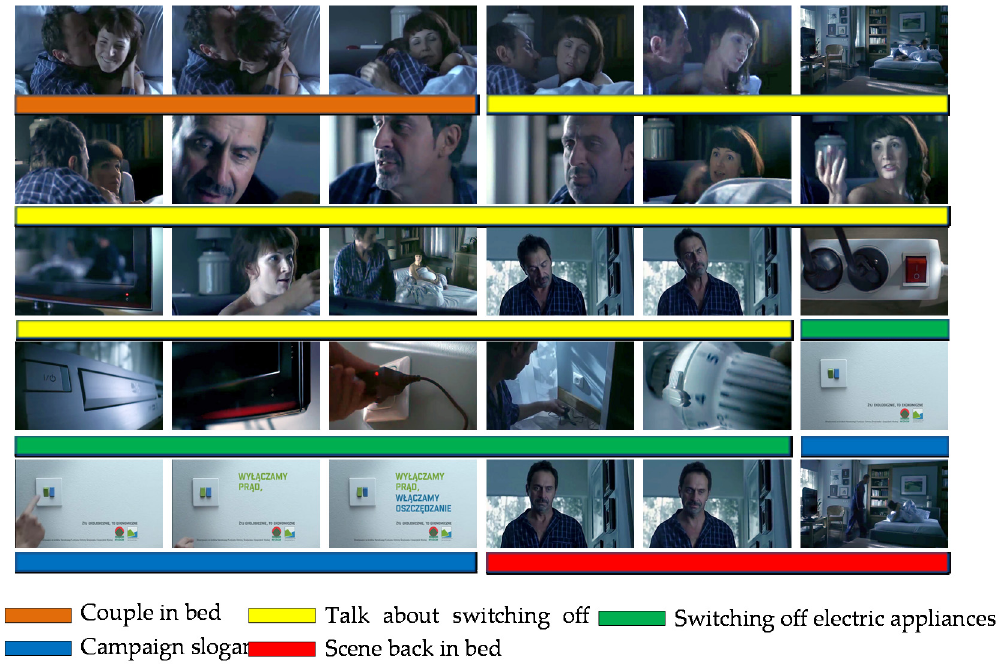
Figure 2. Frame sequence for the media message financed by the Ministry of Environment “turn off power, turn on savings”.